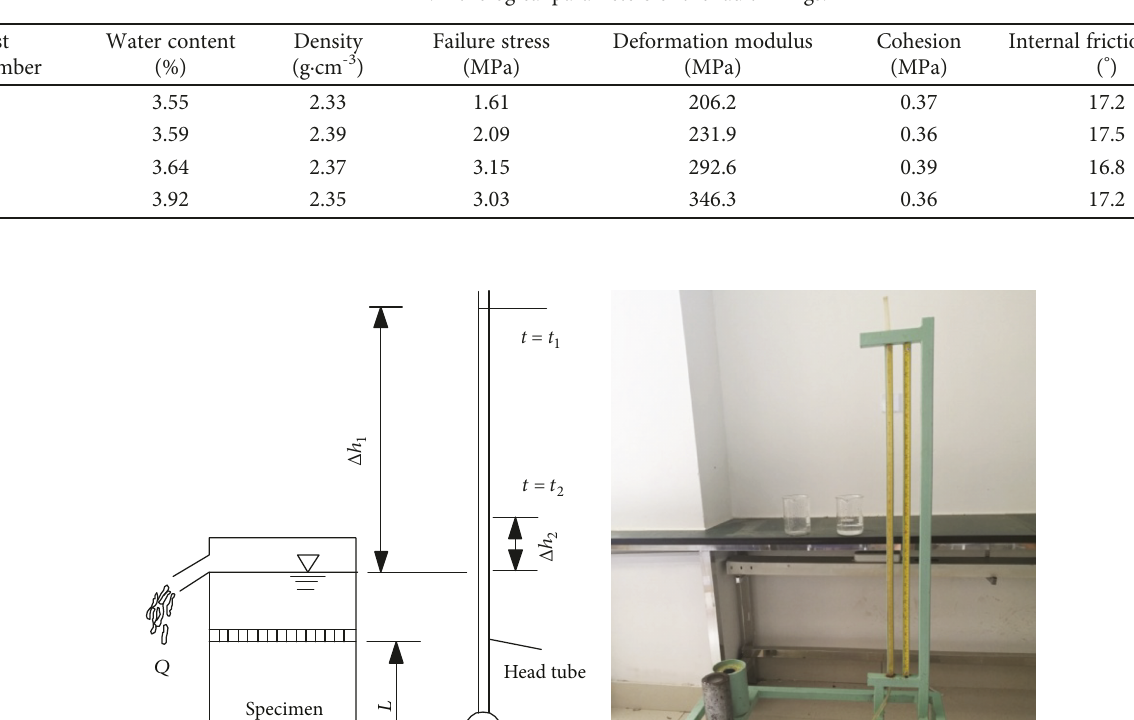
Figure 4: Model geometry and setup: (a) illustration of fault and rock strata and (b) 2D simulation Table 1: Lithological parameters of the fault fi llings.